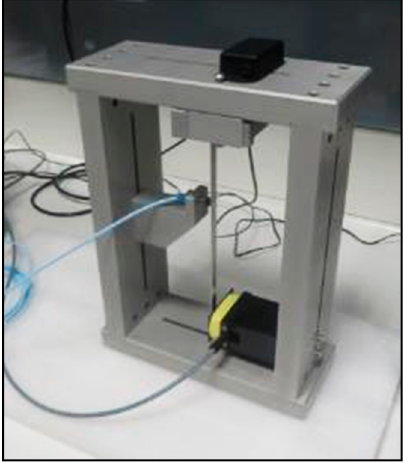
Figure 2. Machine for damping measurement.